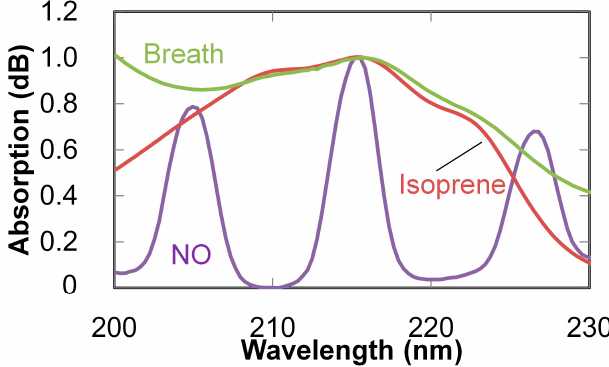
Figure 8. Absorption spectrum of breath (with effect of ozone removed). Absorption spectra of nitric monoxide and isoprene (normalized by peak intensities) are also shown for comparison.